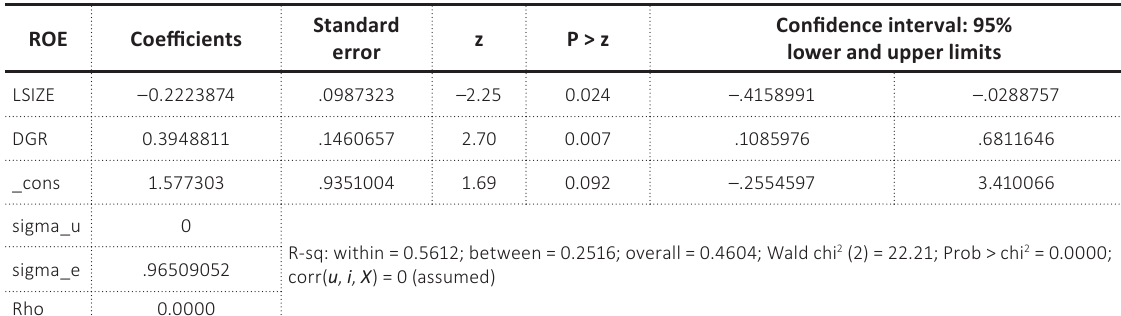
Table 3. Random effects model for post-restructuring